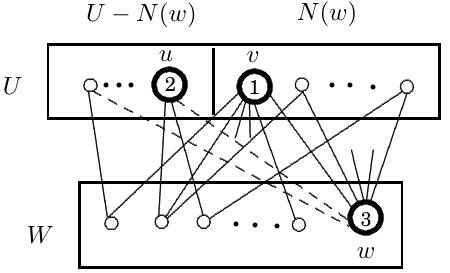
Figure 2: A step in the proof of Theorem